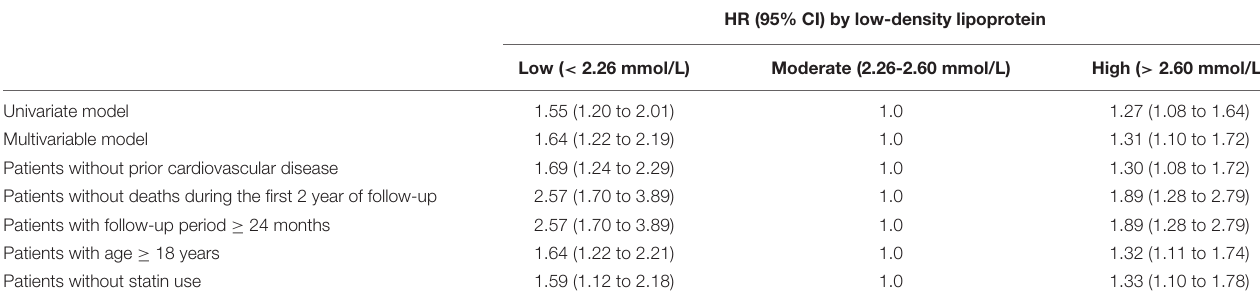
TABLE 4 | Association between low-density lipoprotein cholesterol and cardiovascular